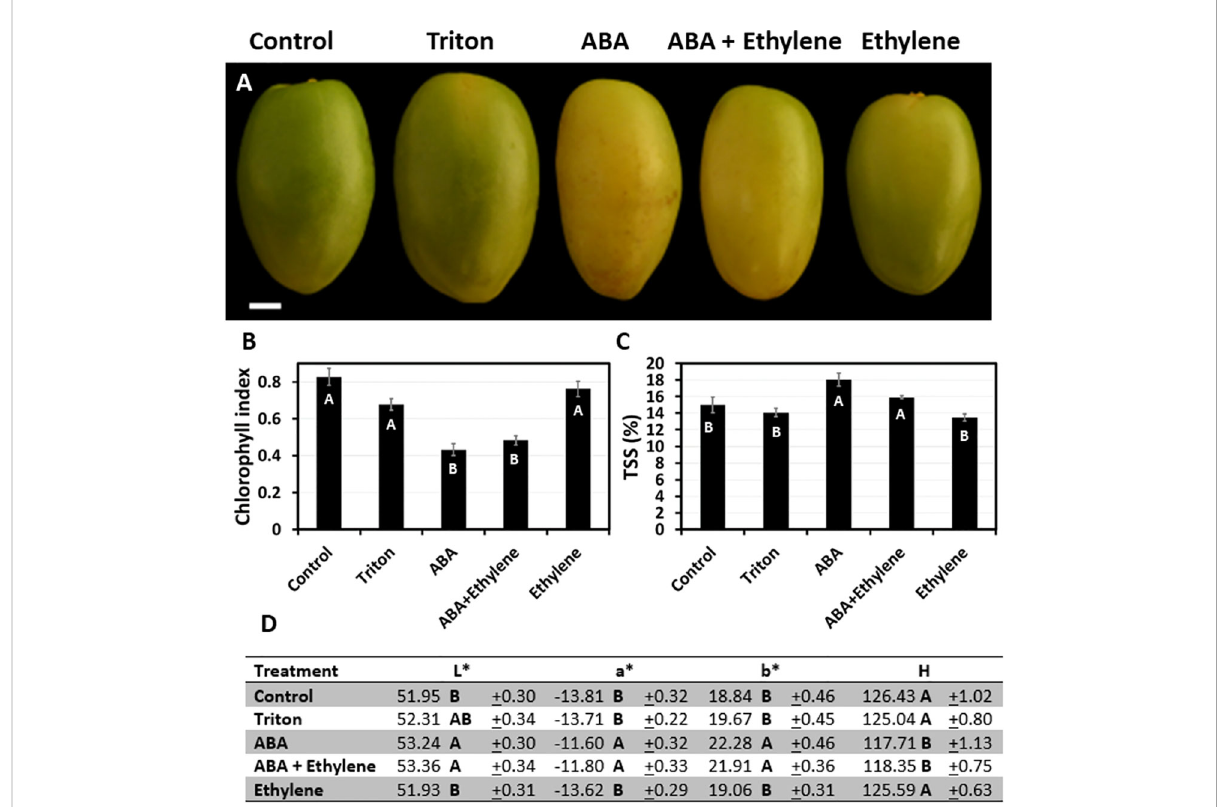
FIGURE 5 The effect of exogenous ABA and ethylene treatment applied at 16 WPP, on date fruit development. Date fruits were treated with a single treatment of ABA (ProTone ™ ), ethylene (Ethrel ® ) or a combination of both, at 16 WPP on the tree (Gro fi t 2017). (A) Representative fruits from each treatment group were sampled and photographed one week after the treatment. Fruit ripening was characterized through quanti fi cation of (B) chlorophyll relative fl uorescence, (C) total soluble solids (TSS; %), and (D) color index. Error bars and “ ± ” indicate standard error. Letters represent Tukey-Kramer multiple comparison test (B ; p-value < 0.0001, C, D; p-value < 0.05 ) . Scale bar: 1 cm. Number of fruits measured per treatment at each time-point: (B, D) n=12, or (C)